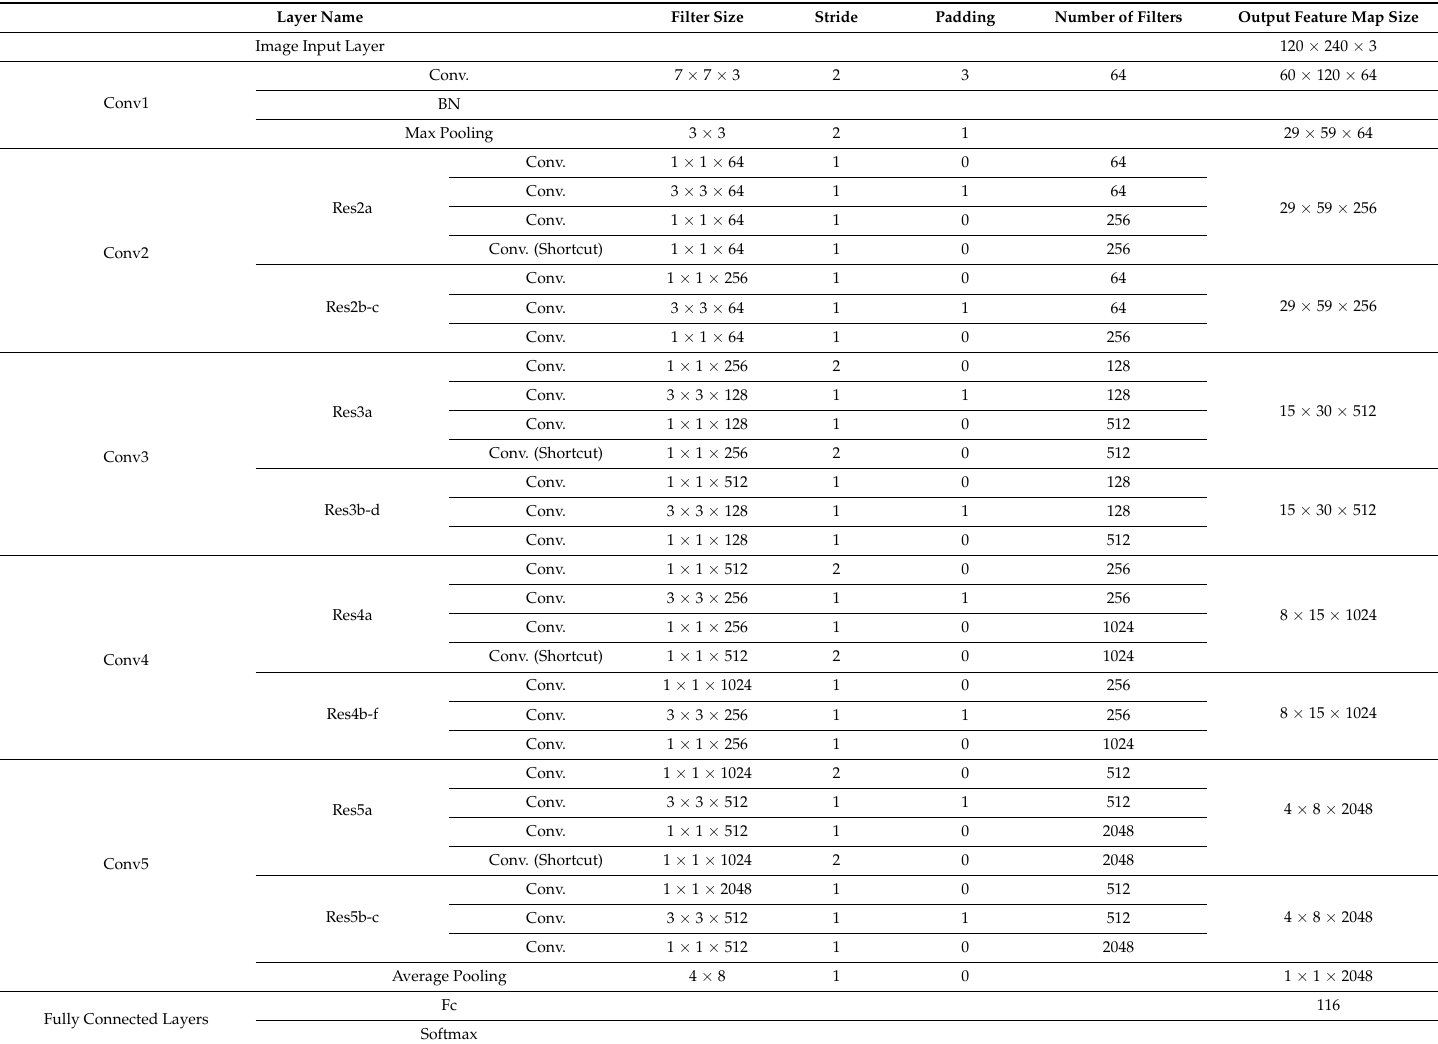
Table 6. Architecture of ResNet-50 used in this study (unit: